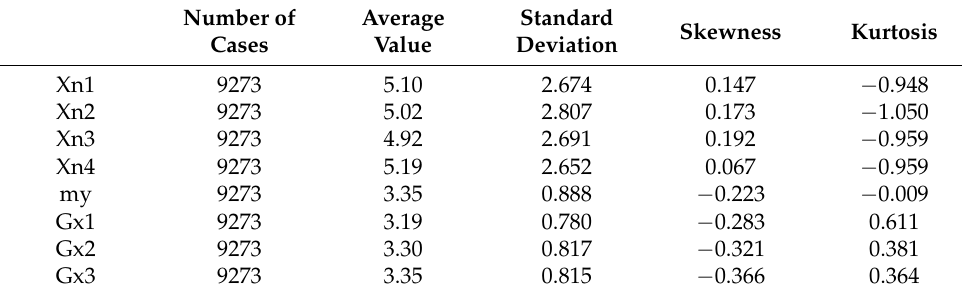
Table 5. Normality test results of the